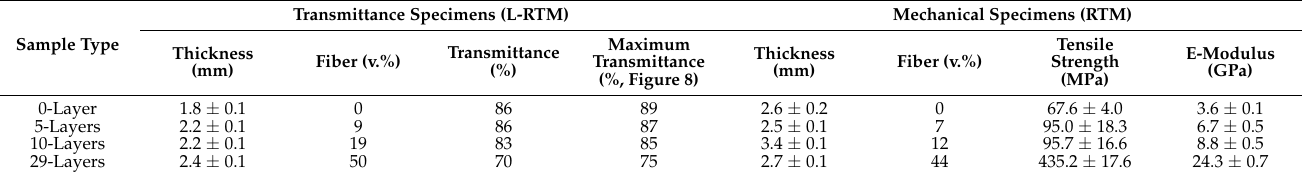
Figure 8. % Transmittance vs. wavelength for samples prepared by L-RTM containing 0, 5, 10, and 29 layers of glass fabric, respectively. Table 3. Summary of the measured optical and mechanical properties of the unfilled polymer and composites containing 5, 10, and 29 layers of glass fiber fabric.